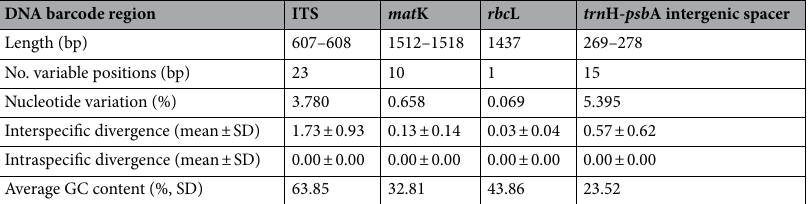
Table 1. Evaluation of the four DNA barcode regions of Mitragyna species used in this study. bp-base pair. SD-standard